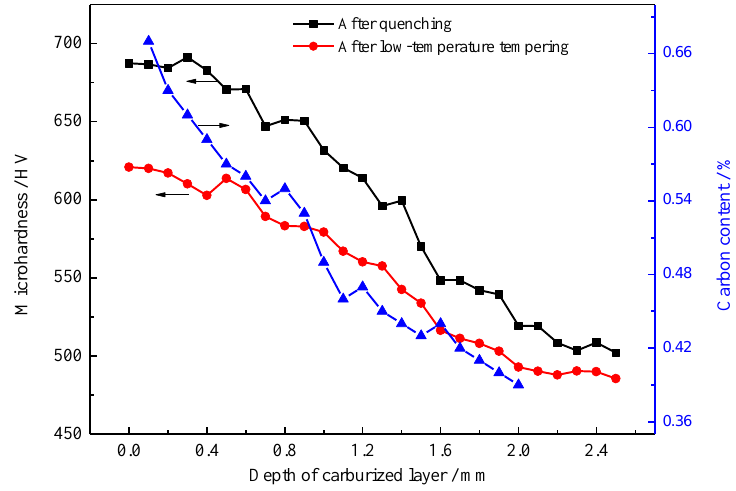
Figure 7. Carbon content distribution and the hardness gradient of the carburized layer.